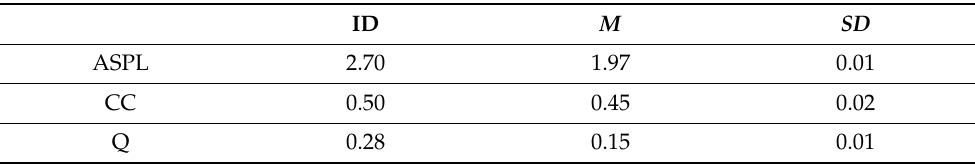
Table A6. Random Network comparison for the network of the adolescents with ID (dataset 5), p < 0.001 for all